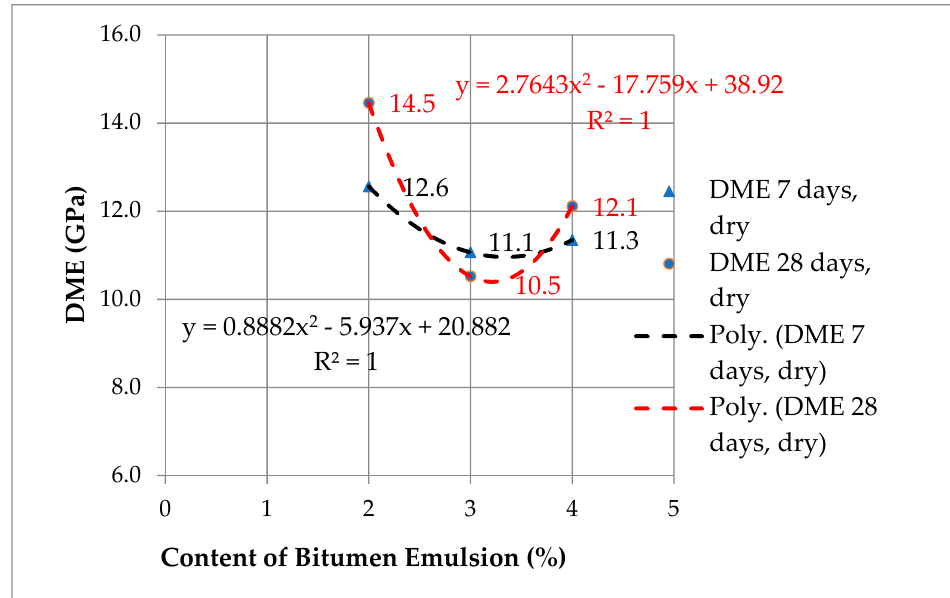
Figure 5. Dependence of dynamic modulus of elasticity (DME) on emulsion content, dry specimens.